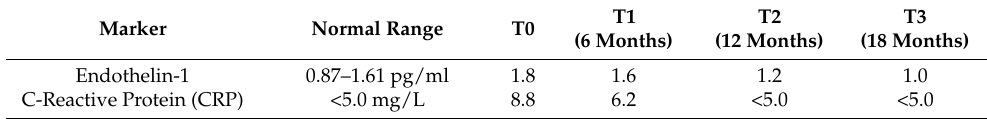
Table 2. Inflammatory markers during follow-up period.